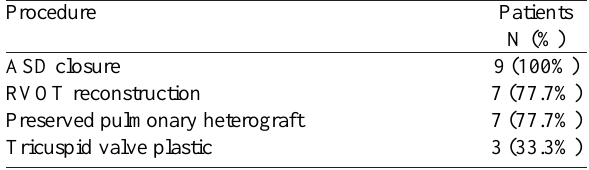
Table 2. Operative procedure: one a half ventricle